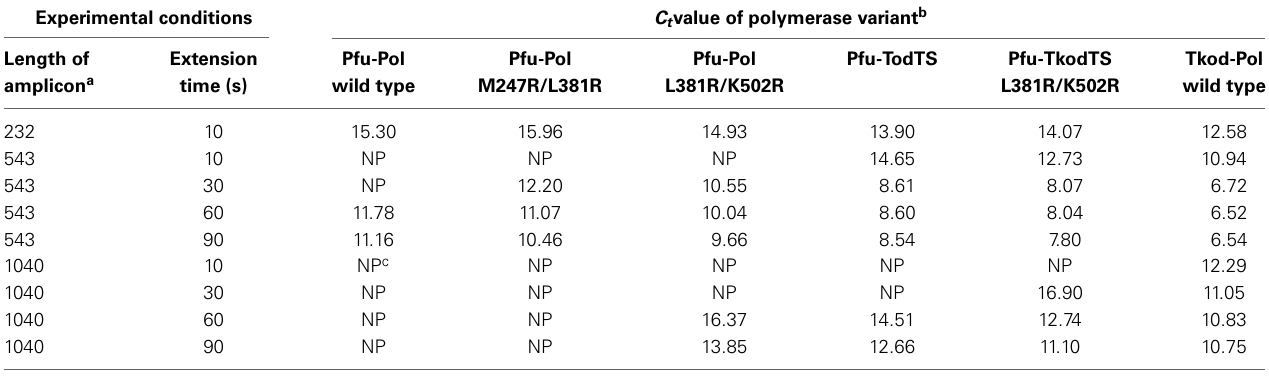
Table 1 | RT-PCR performance of the polymerase variants. Experimental